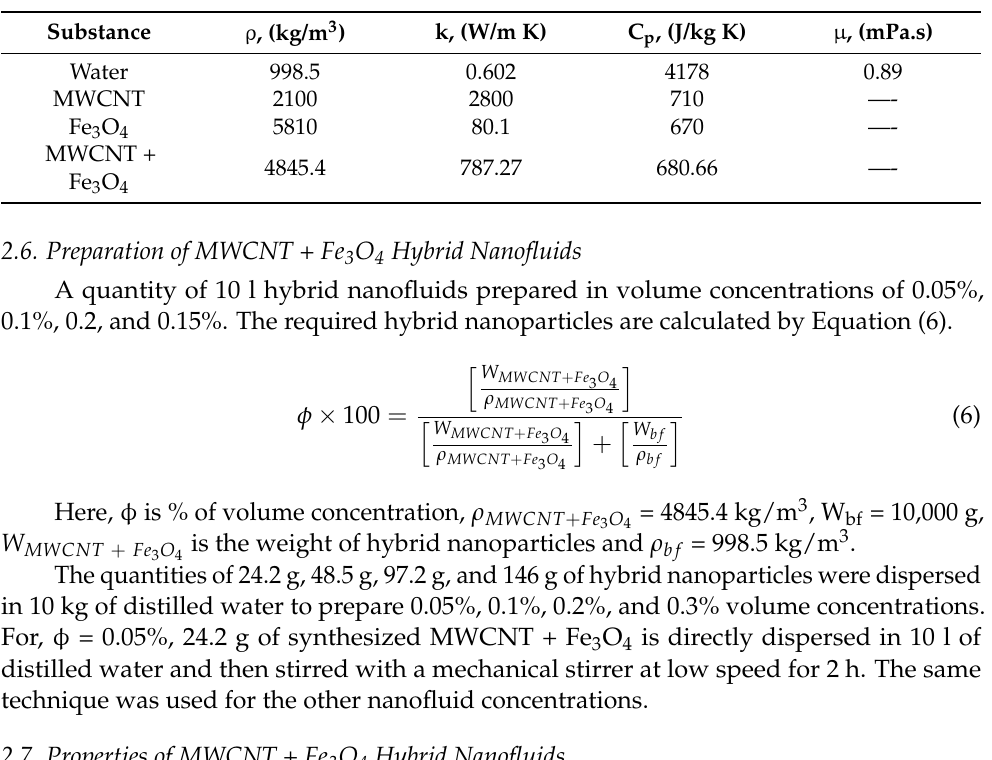
Table 1. Physical property of water, MWCNT, Fe 3 O 4 , and MWCNT + Fe 3 O 4 at 20 ◦